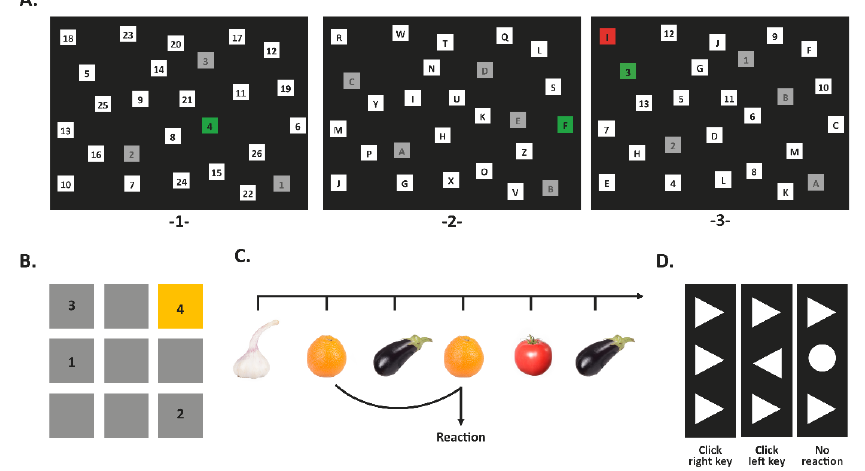
Figure 1. Computerized cognitive task. ( A ) Switch task: visual attention and task switching. The task comprised three sections. (-1-) First section, numbers (non-switch) had to be clicked in ascending order. (-2-) Second section, letters (non-switch) from A to Z had to be clicked alphabetically. (-3-) Third section, number and letters (switch) had to be clicked alternately in ascending order (i.e., 1,A,2,B,3,C). ( B ) Corsi block-tapping task: visual-spatial attention. A sequence of blocks lit up and gradually increased in length up to six blocks. Sequences had to be repeated. ( C ) 2-back task: working memory updating. Fruits and vegetables were displayed on a computer screen. A predefined key had to be pressed when the current image was the same as the image two trials back. ( D ) Flanker task: inhibitory control. Congruent flankers: click right key; incongruent flankers: click left key; no-go (circle): no